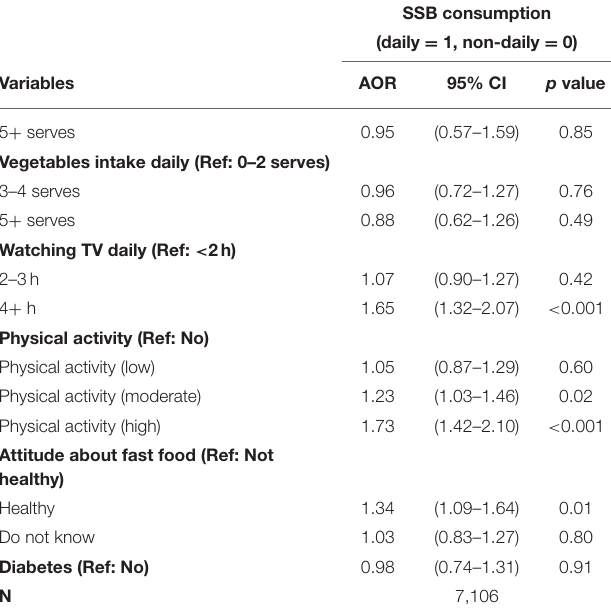
TABLE 4 | Association of daily vs. non-daily sugar-sweetened beverages (SSBs) consumption and study variables among SSB